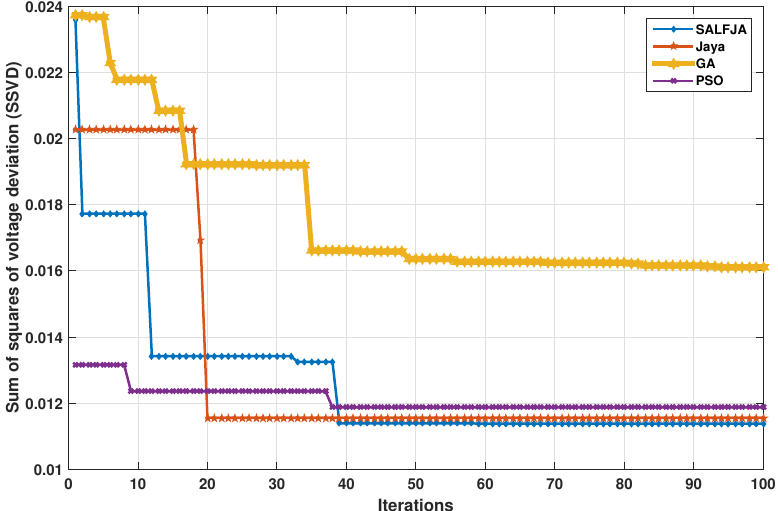
Figure 6. PG and E 69 bus test system: Validation with convergence